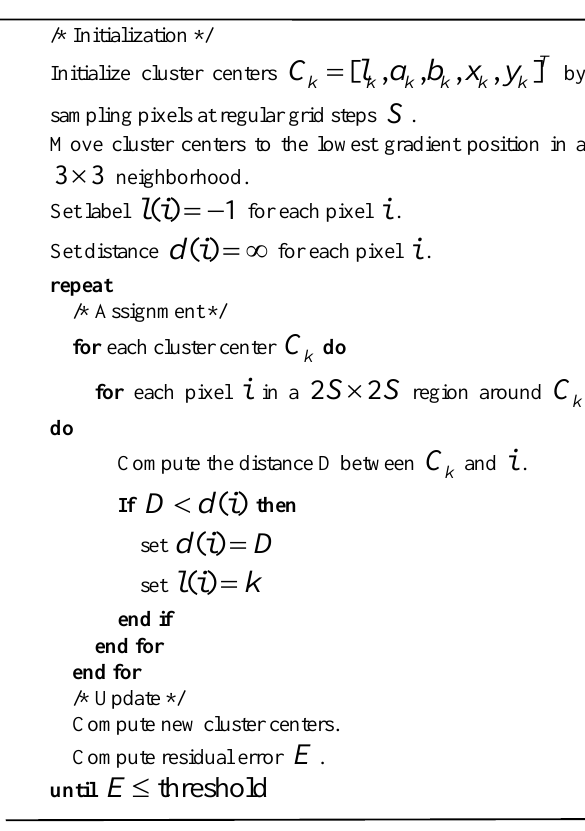
Table 1. SLIC superpixel segmentation. The result of the SLIC segmentation is shown in Fig. 2.